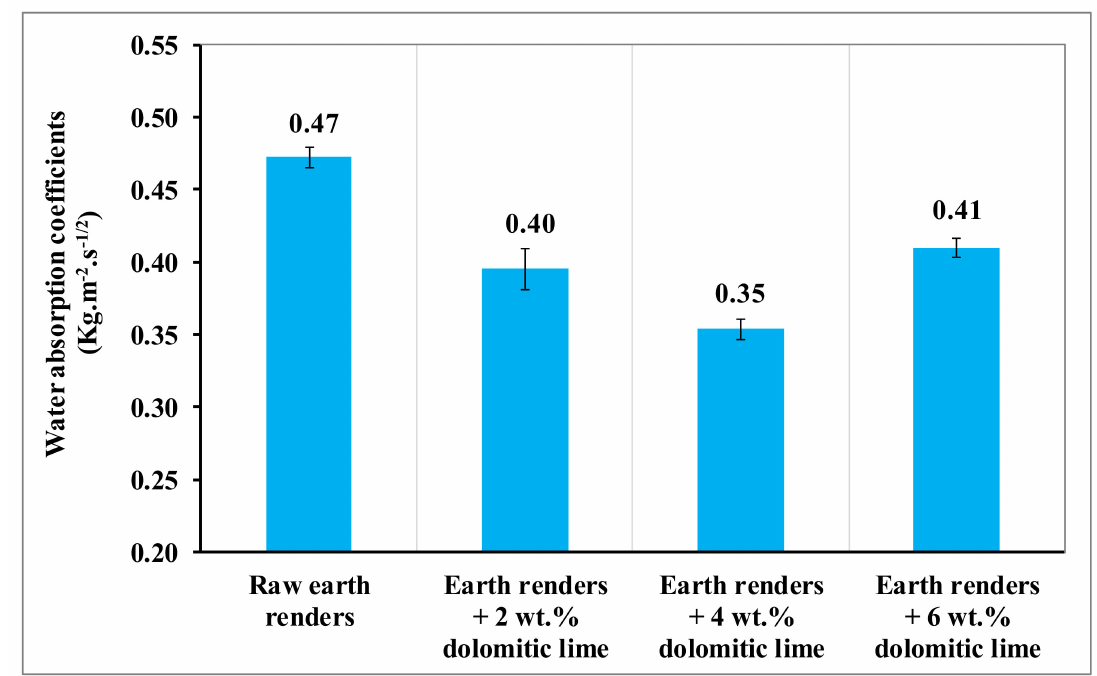
Figure 9. Coefficient of water absorption by capillarity of earth renders samples.